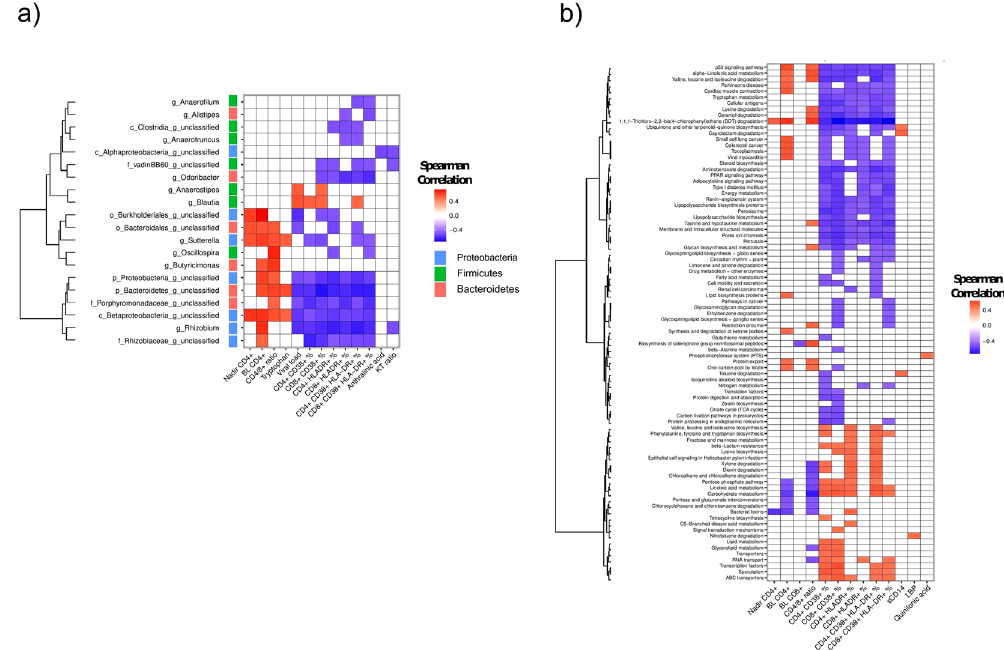
Figure 6. The composition and functionality of gut microbiota correlate with markers of immune activation and inflammation. Most cellular and some soluble markers of immune activation correlated to specific genera and functional pathways of gut microbiota. Correlations are presented by genus ( a ) and functional pathways ( b ). Spearman’s correlation was used. Associations with a Benjamini – Hochberg adjusted p-value lower than 0.01 were considered relevant. Immune activation and inflammatory parameters associated with less than two bacteria were discarded when plotting the